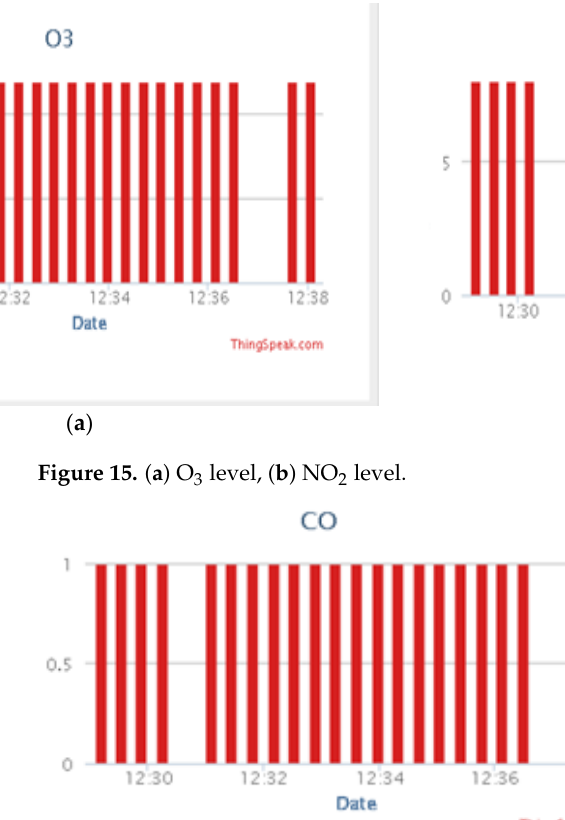
Figure 14. ( a ) PM 10 level ( b ) PM 2 . 5 level.